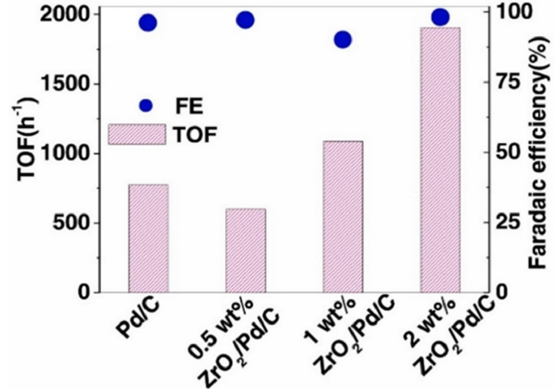
Figure 11. Electrocatalytic hydrogenation of benzaldehyde on Pd/C and ZrO 2 /Pd/C catalysts with different ZrO 2 loadings. Reprinted with permission from Ref [121]. Copyright 2021 Elsevier Inc.